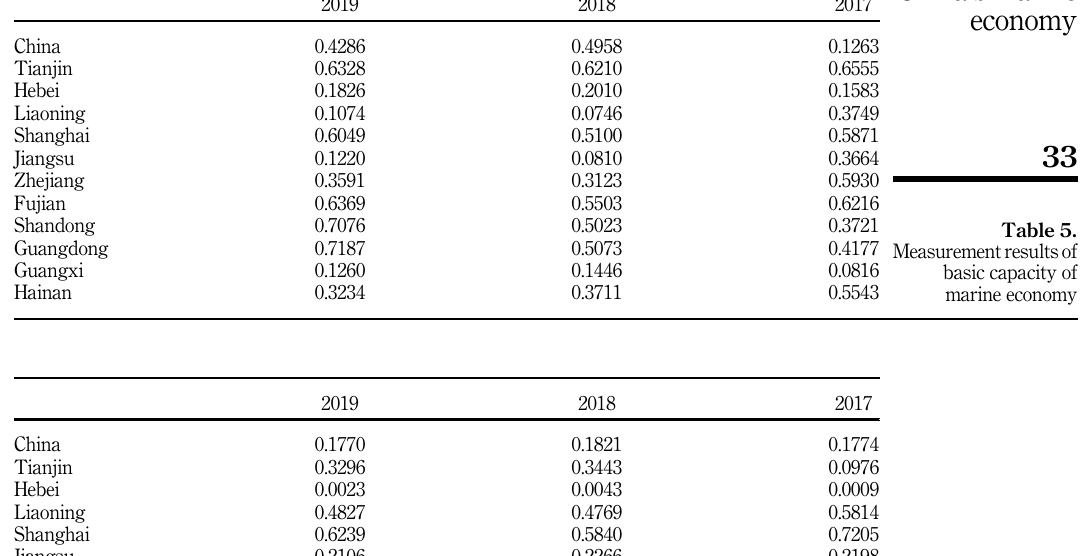
Table 6. Measurementresultsof